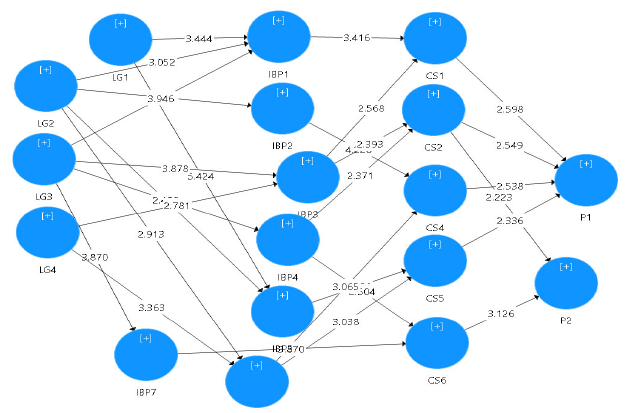
Fig. 5. Final Results of Model 2 Testing